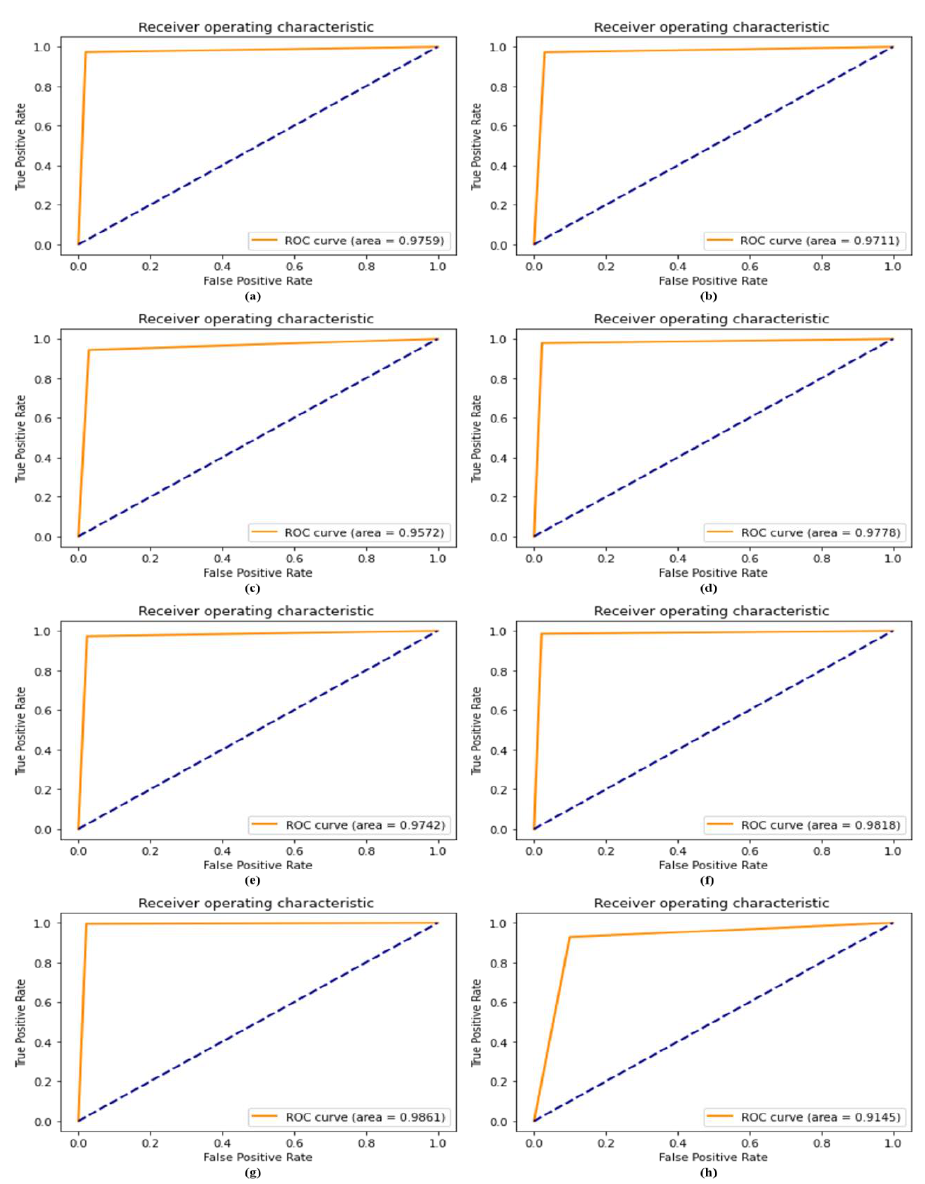
Figure 12. ROC curve comparing the performance of baseline models with the proposed DSCC_Net model; ( a ) Vgg-16, ( b ) Vgg-19, ( c ) EfficientNet-B0, ( d ) ResNet-152, ( e ) Inception-V3, ( f ) MobileNet, ( g ) Proposed Model with SMOTE Tomek, and ( h ) Proposed Model without SMOTE Tomek.